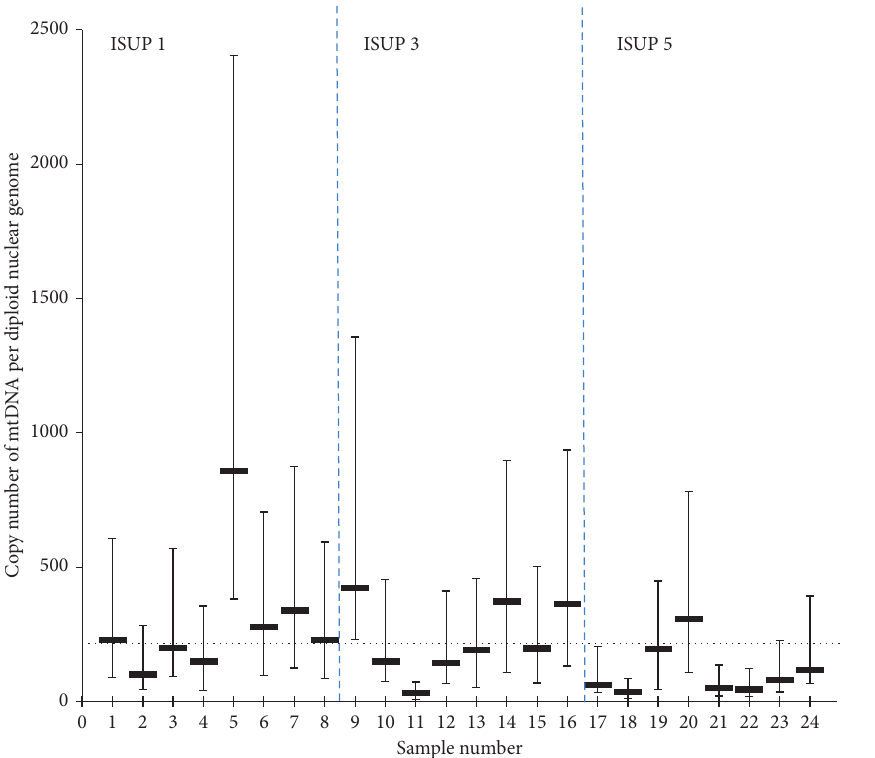
Figure 5: The average mtDNA copy number analyzed by real-time PCR on sample DNA. Data are plotted as average ± 1 standard deviation from eight analytical replicates. Pairwise numbers, 1, 2, 3, and 4, etc., represent the same prostate, respectively. The horizontal line shows the mean copy